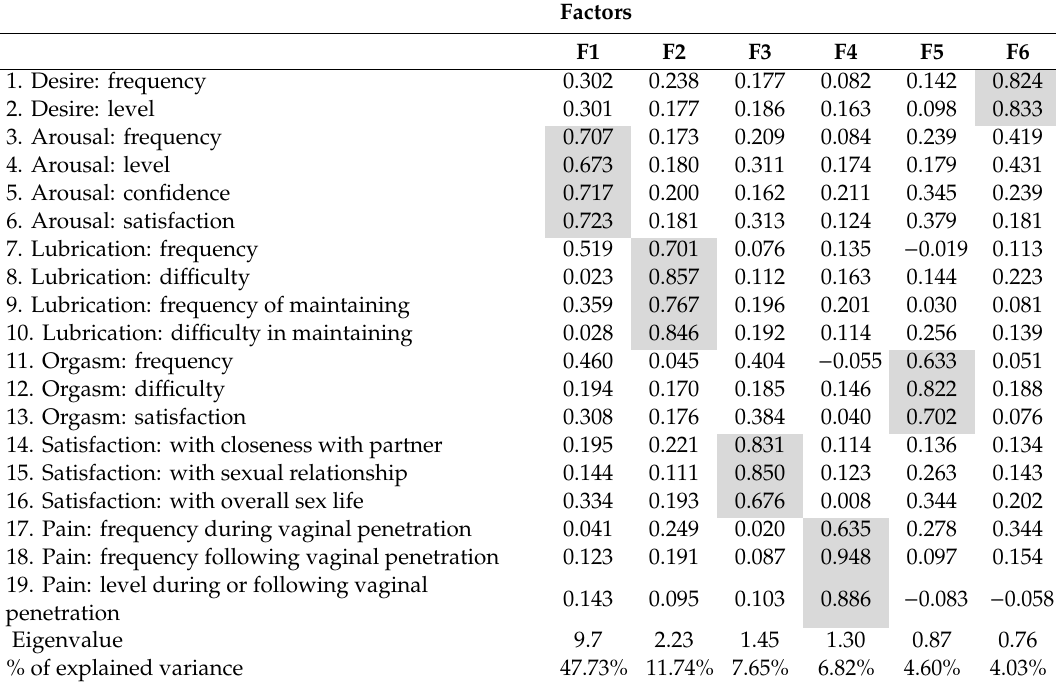
Table 4. Factor analysis of the FSFI: factorial validity (N = 323).